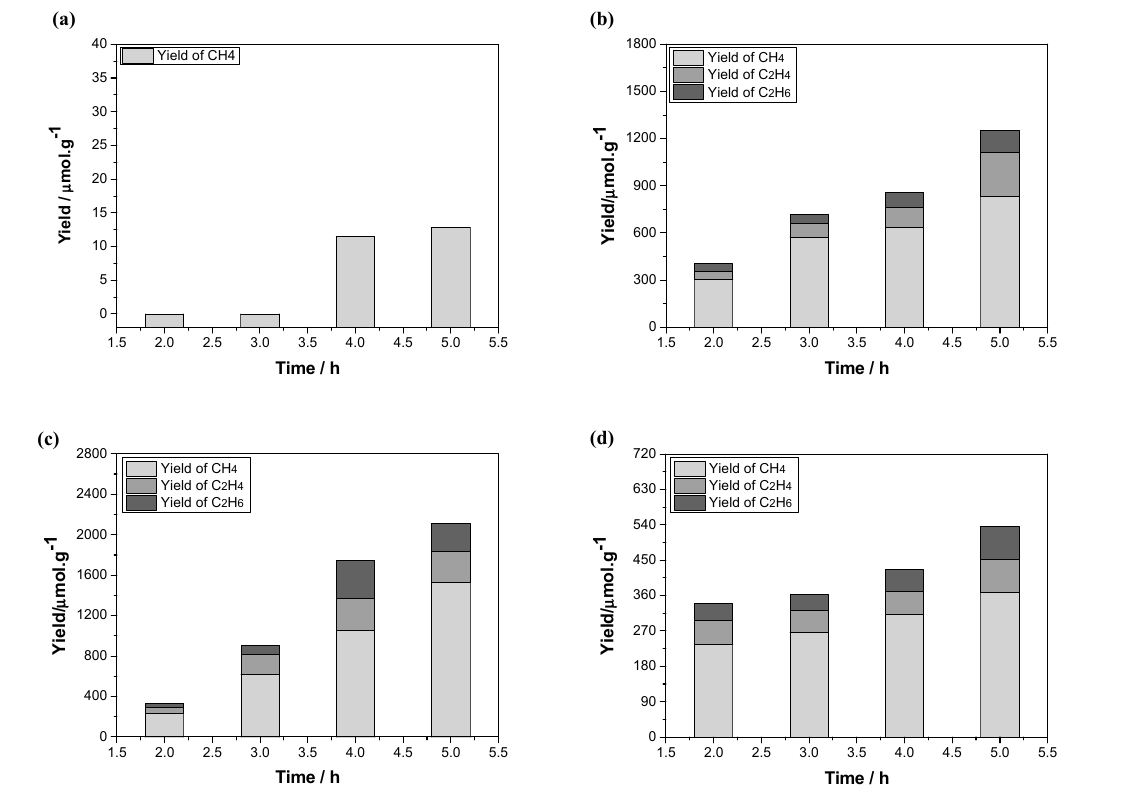
Figure 1. CO 2 photoreduction behavior of Bi 2 WO 6 /WO 3 under different concentration ratios (CRs): ( a ) natural light (CR = 1, 60 ◦ C); ( b ) natural light (CR = 400, 300 ◦ C); ( c ) natural light (CR = 600, 400 ◦ C); ( d ) natural light (CR = 800, 500 ◦ C). Table 1. STC average efficiencies of Bi 2 WO 6 /WO 3 under concentrating solar light.